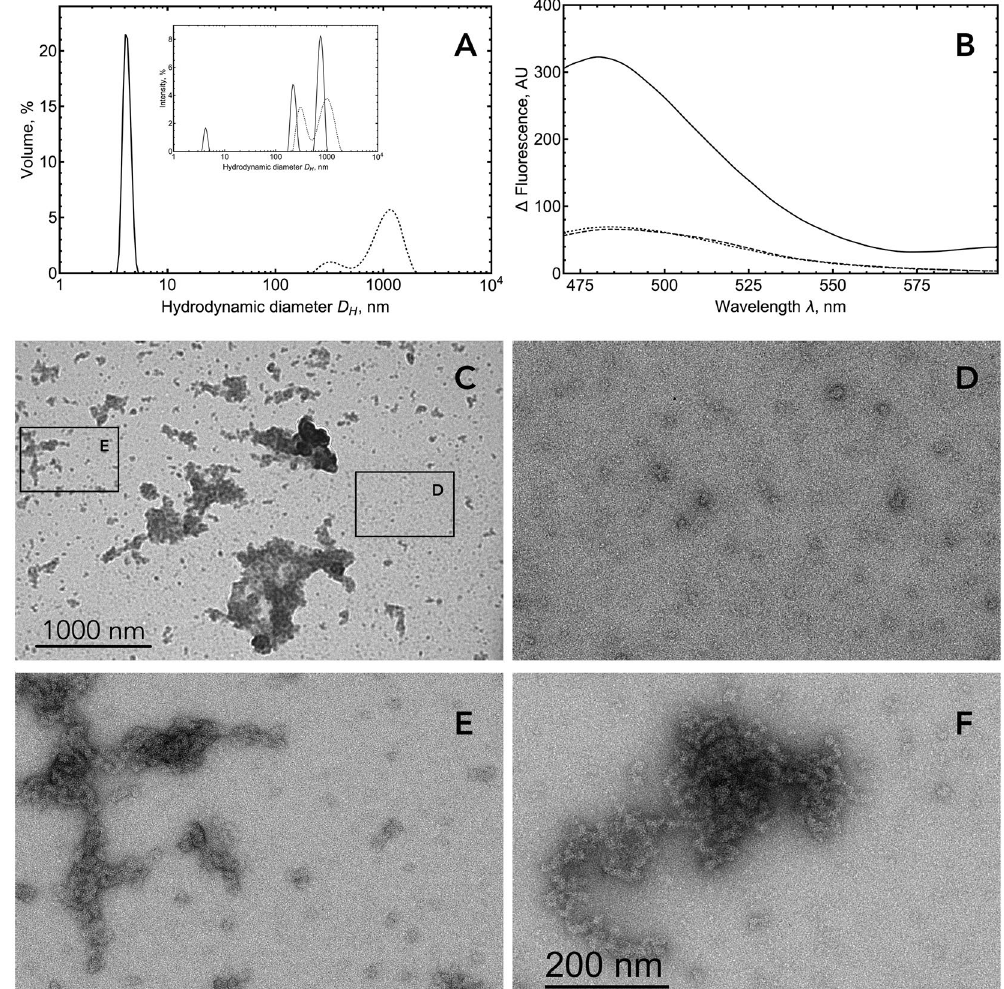
Figure 5. ( A ) DLS analysis of RRM12 using Zetasizer NanoS Malvern instrument. Size distribution by volume and intensity (insert) of 10 µ M RRM12 in the absence (solid curve) and in the presence of 10 µ M zinc ions (dotted curve). ( B ) Fluorescence spectra of 10 µ M RRM12 sample in the absence (dashed line) and in the presence of 10 µ M zinc ions (solid line). ThT concentration was 18 µ M. Control spectra for ThT alone in buffer (dotted curve). ( C ) Representative electron micrographs of negatively stained TDP-43 aggregates and zoomed-in images of small oligomers ( D ) and tangled rope-like aggregates ( E , F